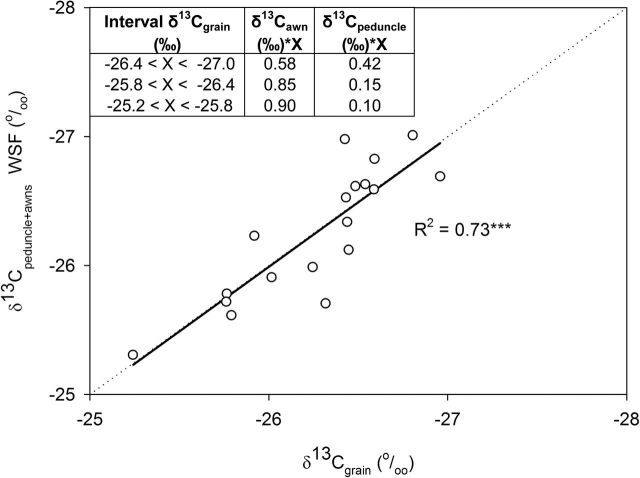
Linear regression of the relationship between the stable carbon isotope composition in mature grains (δ13Cgrains) and the combination of δ13C from awns and the peduncle (δ13Cawns+δ13Cpeduncle) in the WSF. The individual values of δ13Cawn and δ13Cpeduncle used in the linear regression were the average of the δ13C in the WSF before and after irrigation. The six genotypes with three replications per genotype were considered, accounting for a total of 18 plots. For each plot, the relative weight assigned to the δ13C of each of the two organs depended on the water status of the plot assessed by its δ13Cgrains (see inset). Level of significance: ***P<0.001.